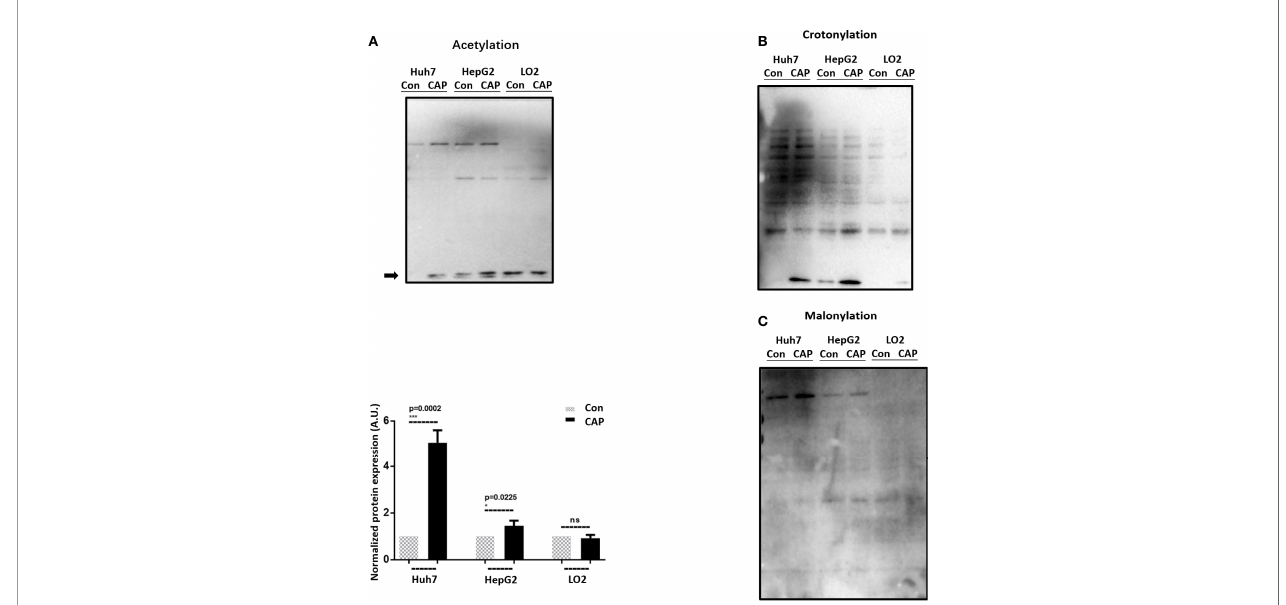
FIGURE 2 | CAP selectively affects acetylation in HCC cells. Western blots and quanti fi cations showing the expression pro fi les of (A) acetylation, (B) crotonylation, and (C) myristoylation in Huh7, HepG2, and LO2 cells with and without CAP treatment. Quanti fi cations were made from triplicates for panel (A) . *, ***: statistical signi fi cance. ns: there is no statistical signi fi cance.